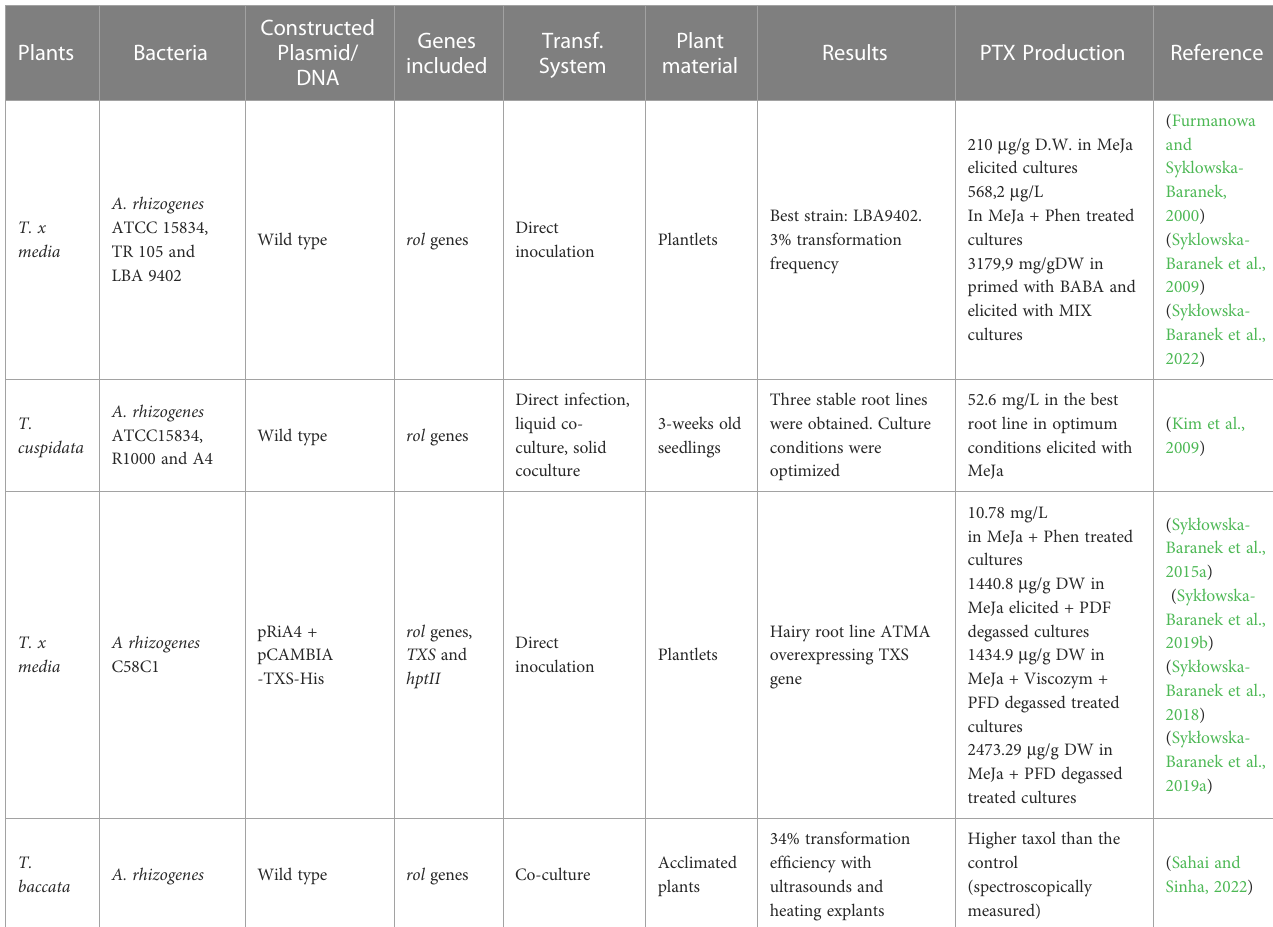
of elicitation with MeJa.